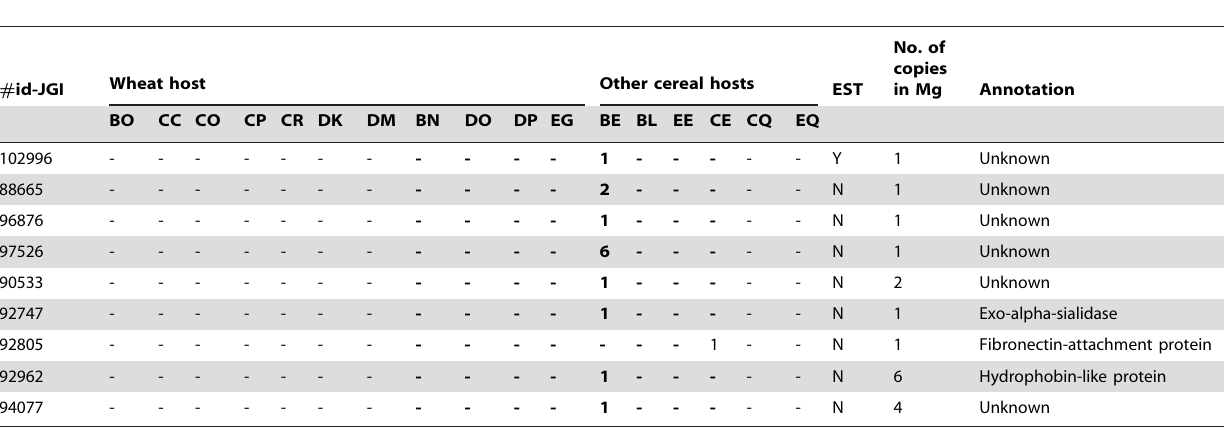
Table 12. Number of putative secreted proteins from Mycosphaerella graminicola secretome only found in fungal pathogens of wheat plants or other